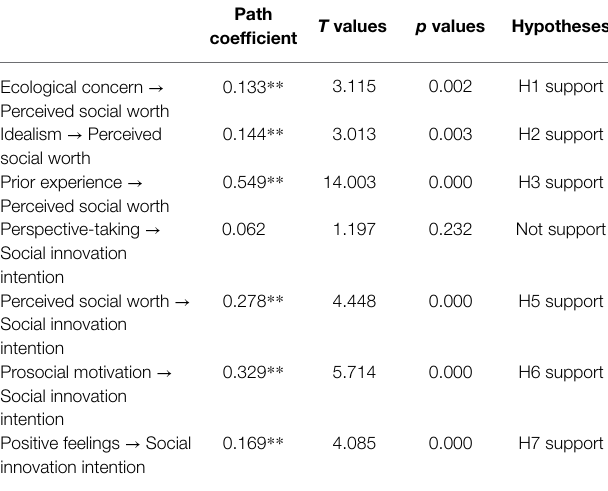
TABLE 4 | Estimation results for